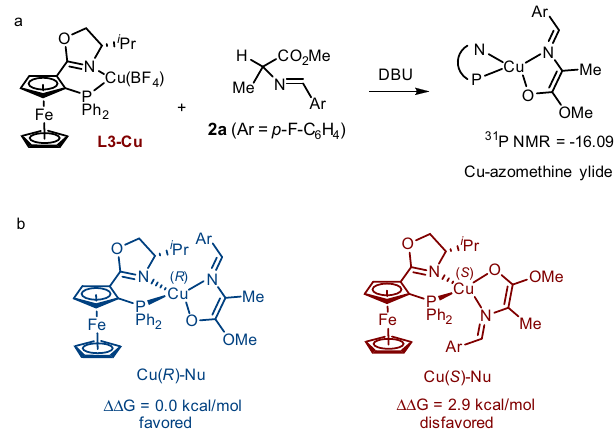
Fig. 7 Determination of the structure for the Cu-azomethine ylide. a Observation of the Cu-zaomethine ylide by 31 P NMR. b Energy comparison of Cu( R )-Nu and Cu( S )-Nu.